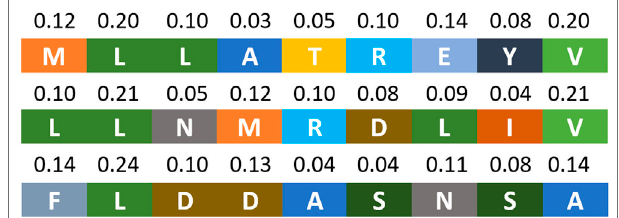
FIGURE5| AttentionweightsofthreepeptidesforHLA-A*02:01learned from ConvM .